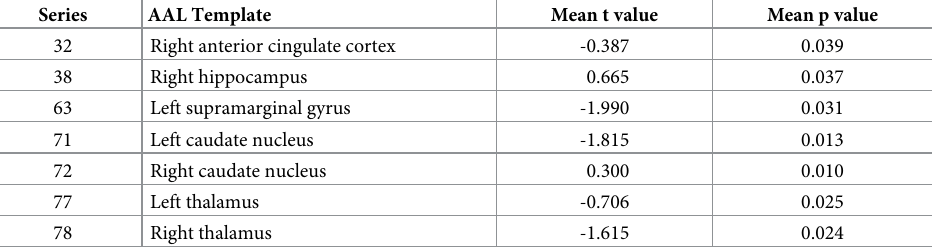
Table 2. Brain regions with significant group differences in characteristic path length between the CCH and con- trol groups (corrected p < .05). Series